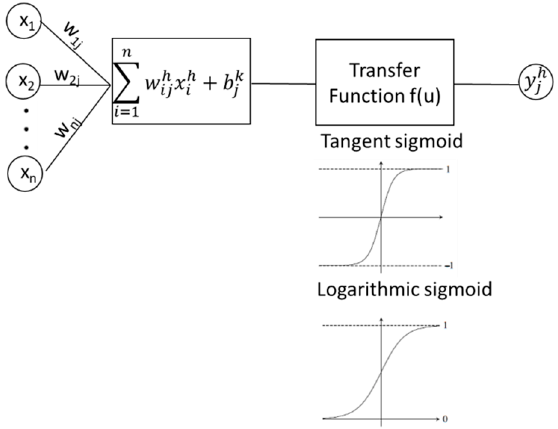
Figure 2. The generic model of neuron j in hidden layer h.